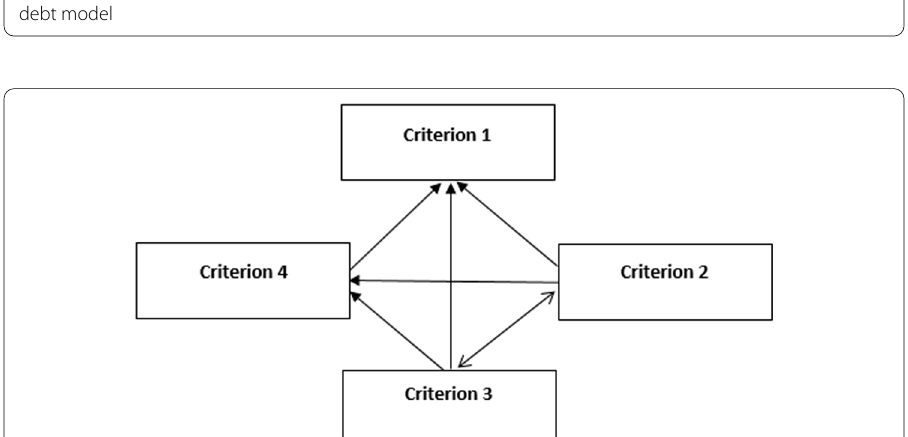
Fig. 5 Impact-relation directions of consensus-based multidimensional due diligence for equity sharing model